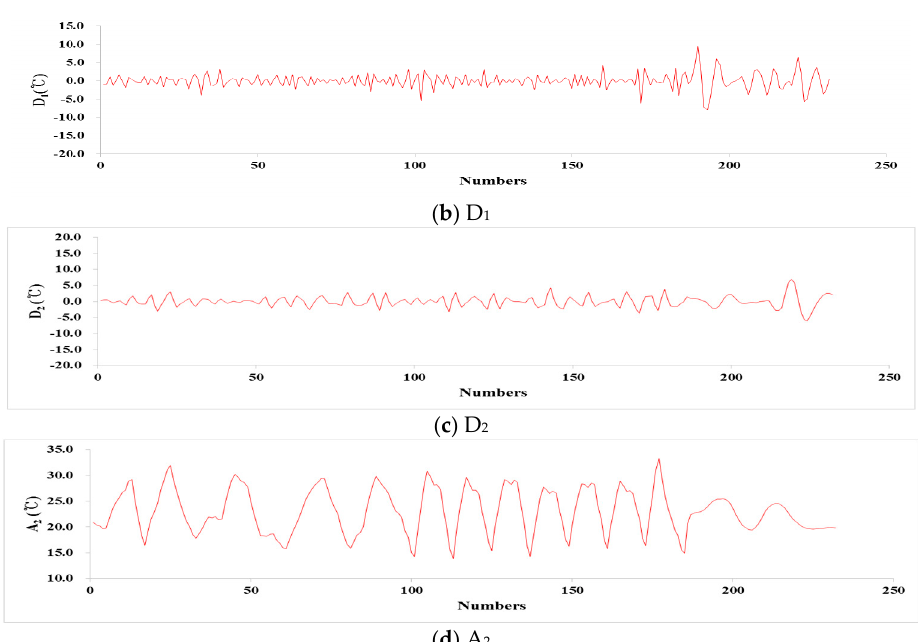
Figure 9. Original water temperature and sub series (details (D 1 and D 2 ) and approximation (A 2 ) components) decomposed using Symmlet-6 (S6) mother wavelet.